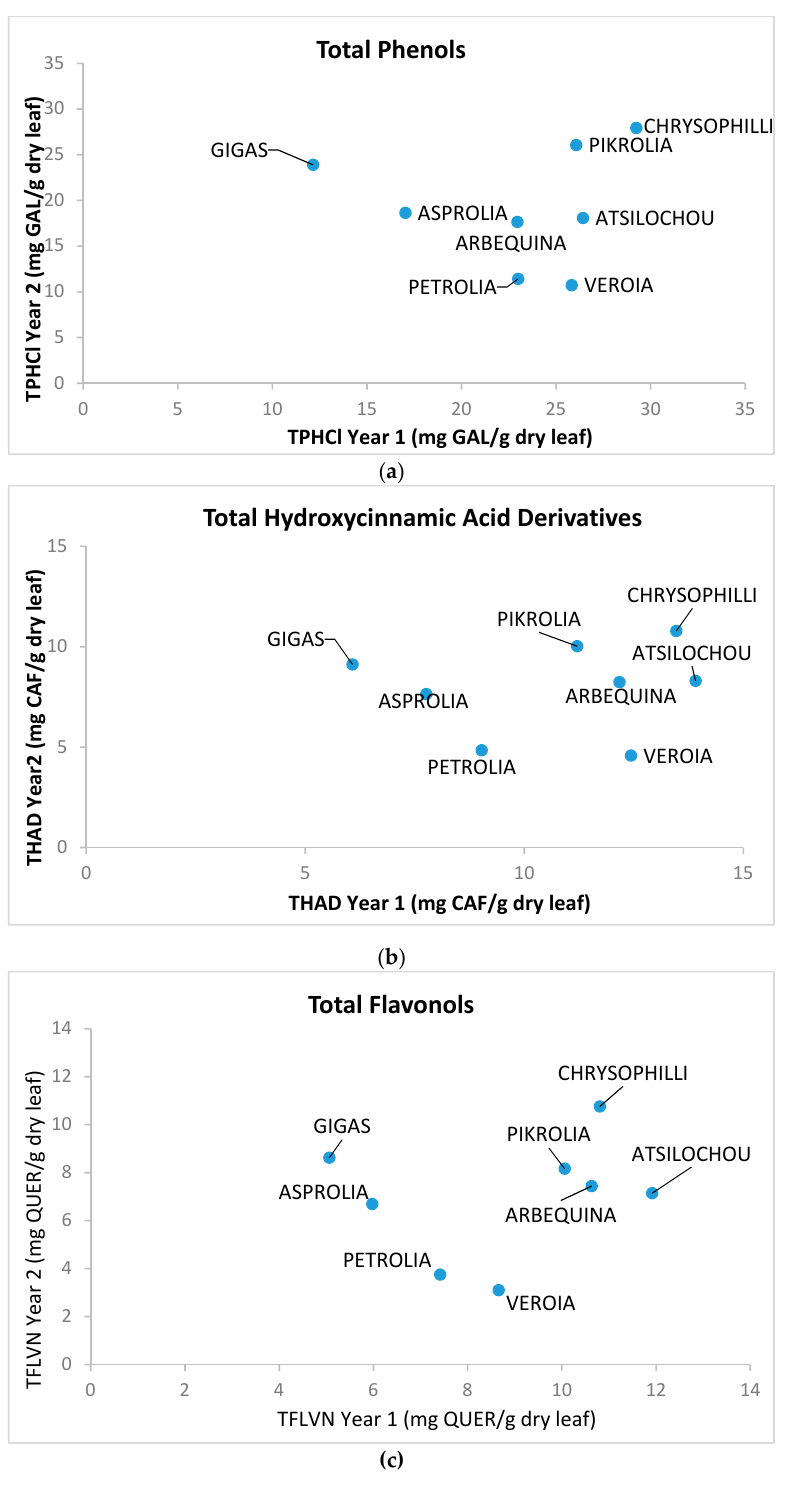
Figure 8. Comparative representation of ( a ) total phenol content determined via the alternative spectrophotometric assay (TPHCl), ( b ) total hydroxycinnamic acid derivatives (THCAD), and ( c ) total flavonols (TFLVN) data for the methanol extracts prepared from olive leaves from two sampling periods: year 1 (2012) and 2 (2013).